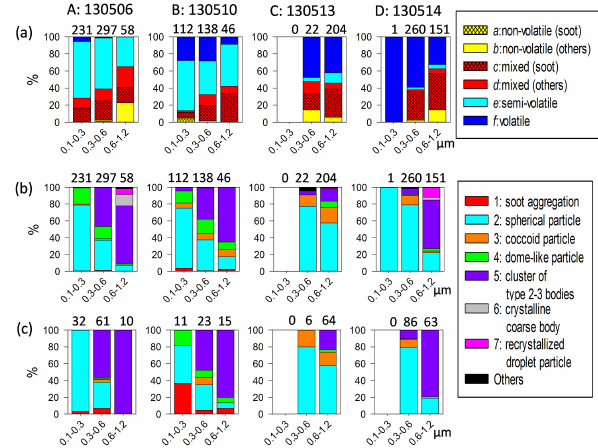
Figure 10. Size-segregated number proportions of (a) mixing state particle types on the basis of the classification in Fig. 9, (b) mor- phological particle types on the basis of the classification in Fig. 8 and (c) morphological particle types of soot-containing particles for samples A–D. The numbers above the columns show the number of particles